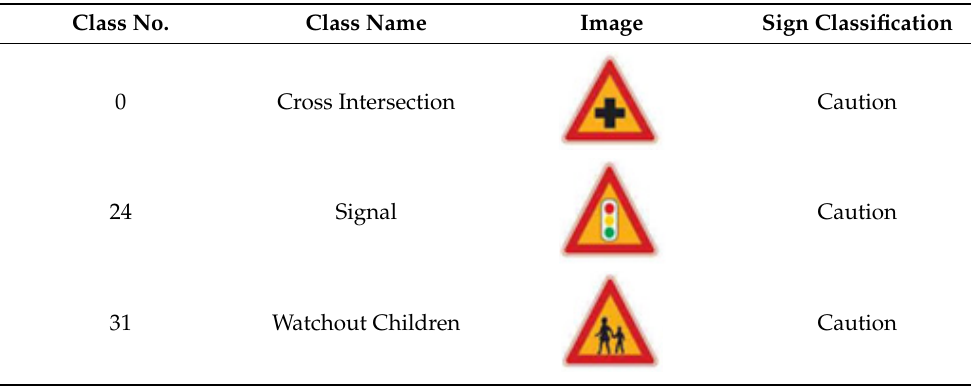
Table 2. Examples of traffic sign classifications: Caution, Regulation, Indication signs. Class No.